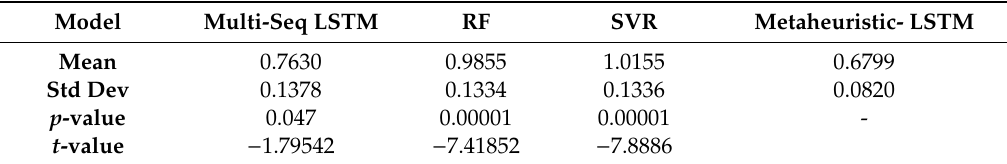
Table 5. Two-sample t -test for di ff erences in the mean CV(RMSE).